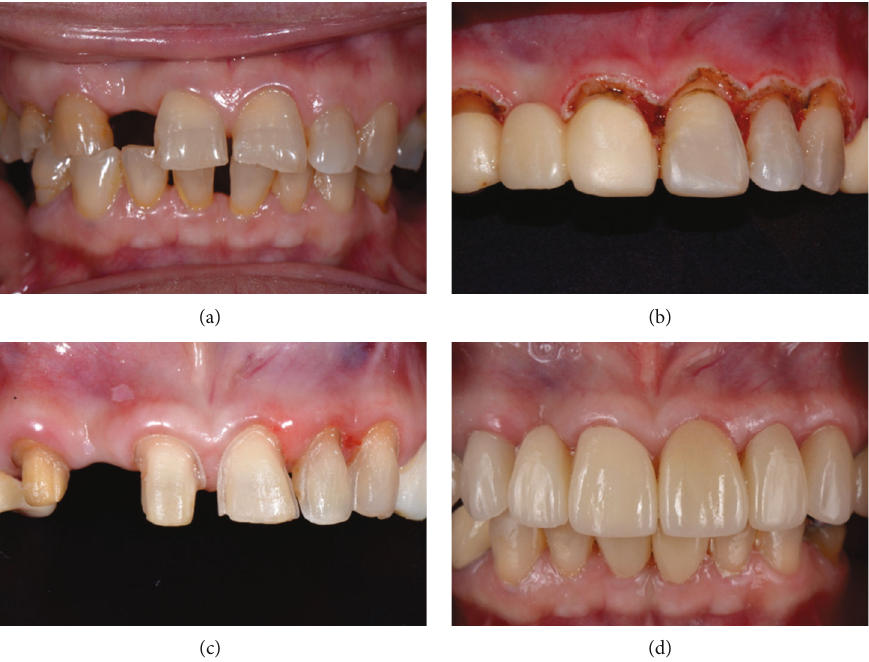
Figure 3: (a) Moderately worn down maxillary anterior teeth and missing a right lateral incisor. (b) Gingivectomy performed with the diode laser. (c) Final tooth preparation on healed gingiva. (d) Final prosthesis cemented showing good crown length and gingival harmony.